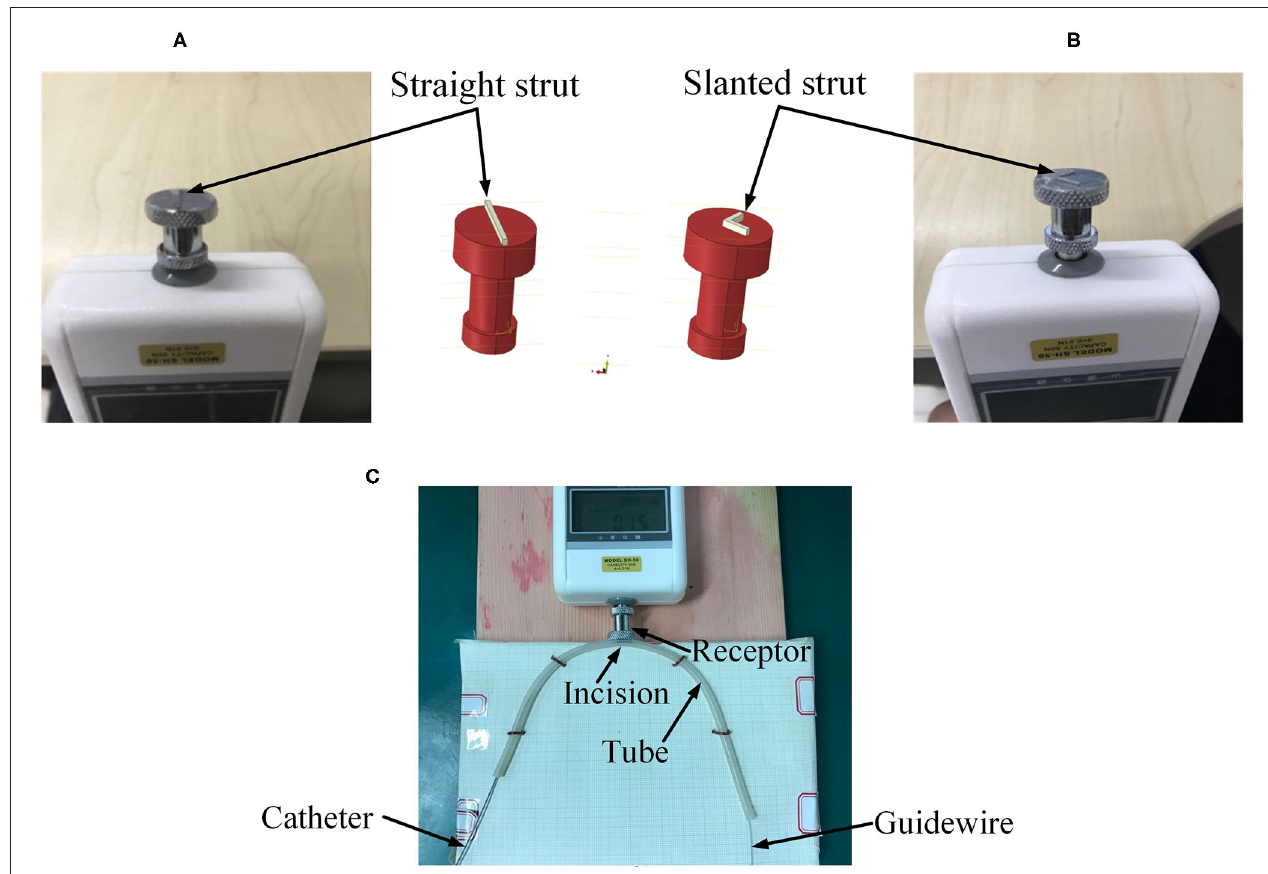
FIGURE 5 | Experimental setup. (A) Straight strut, (B) slanted strut, and (C) assembled experimental model.